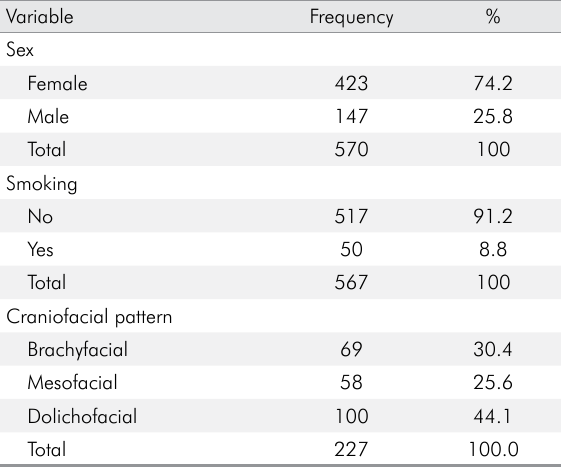
Table 3. Miniscrews failure according to age.